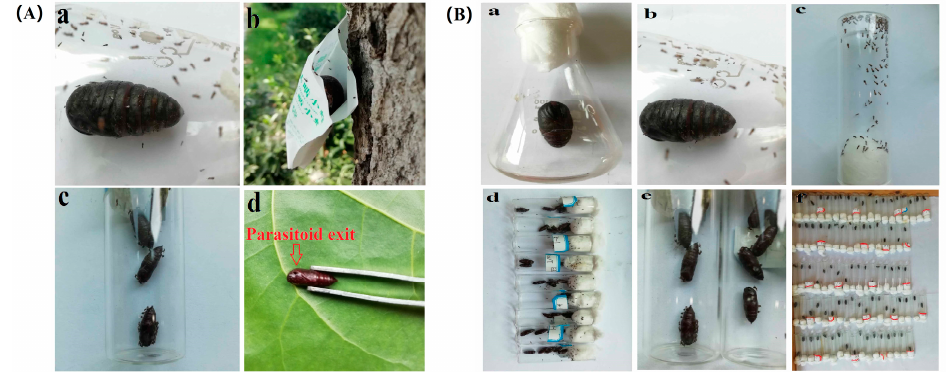
Figure 3. The experiment of parasitic natural enemy. ( A ) C. cunea . a , b : A. pernyi pupa parasitized by C. cunea . c , d : Pupa of H. cunea parasitized by C. cunea . ( B ) Procedure of the parasitoid experiment; a : tussah pupa, b : C. cunea production, c : sub-package, d , e : parasitism process, f : sub-package.